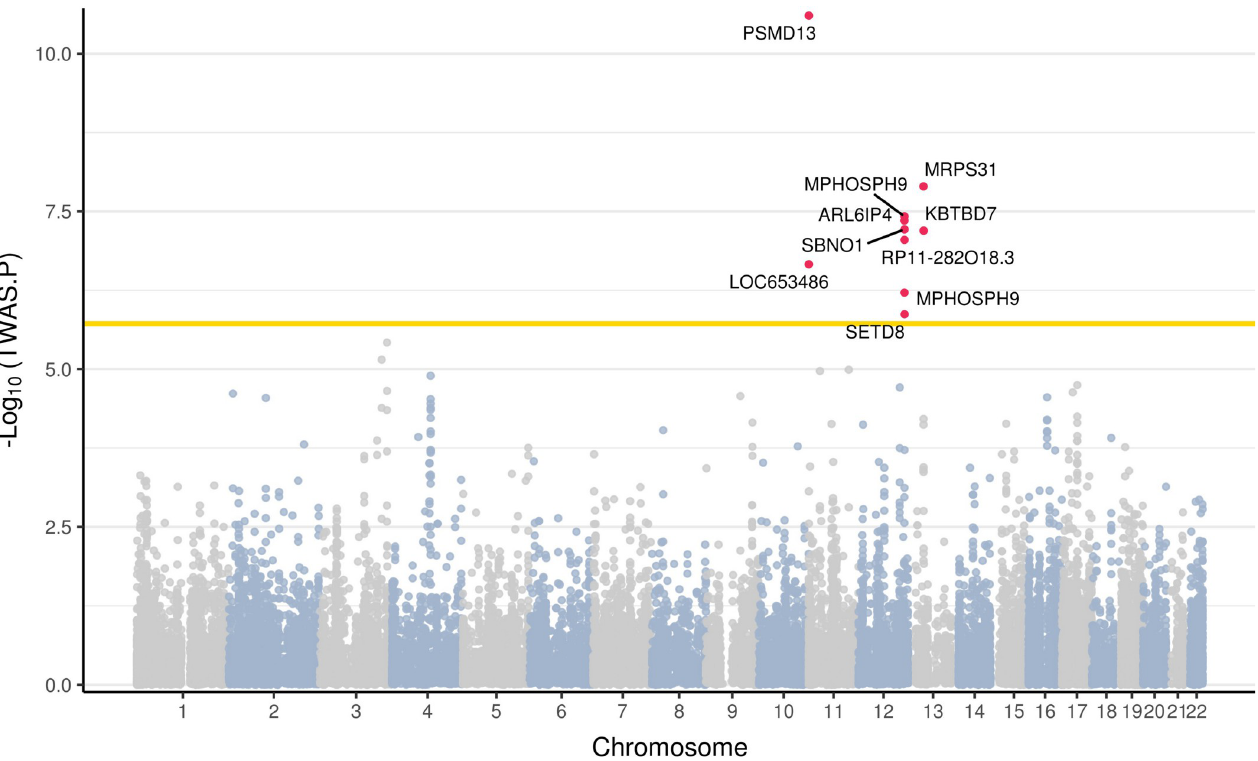
Fig 1. A Manhattan plot of the TWAS results for UF. Each dot corresponds to the gene of which predicted expression is associated with UF. The X-axis denotes the chromosome numbers of the genes and the Y-axis denotes − log 10 (TWAS P-values). The yellow line indicates a Bonferroni significant threshold (P < 1.90 × 10 − 6 ). Nine significant TWAS genes are represented as red dots with gene labels.